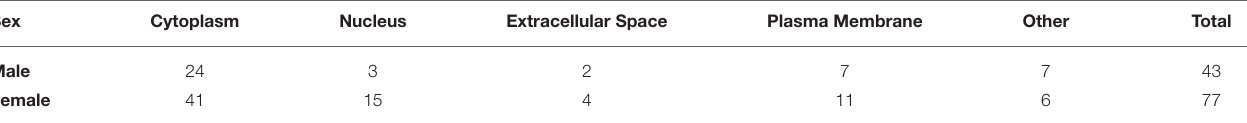
TABLE 1 | Subcellular localization of K48 polyubiquitin